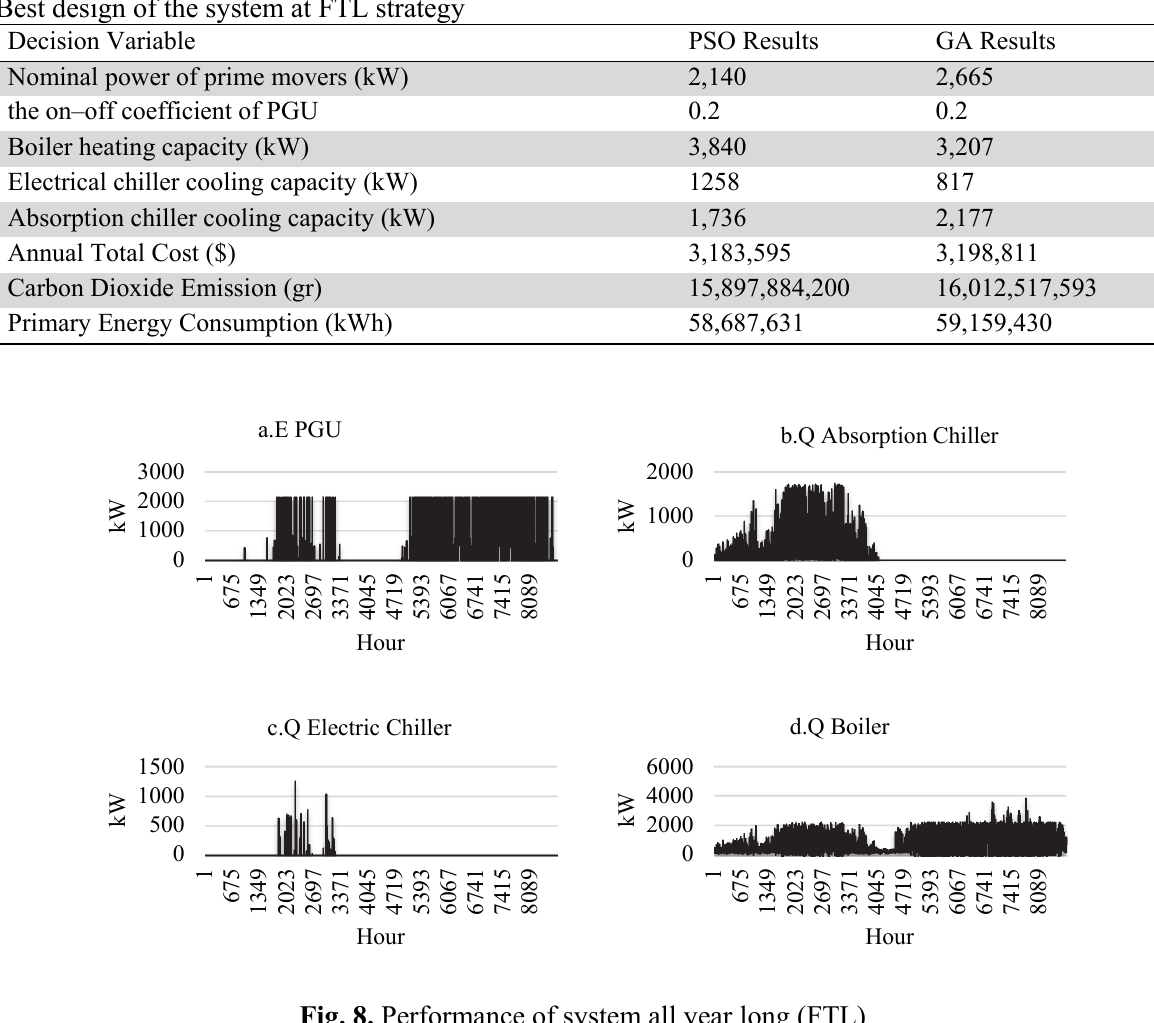
Fig. 8. Performance of system all year long